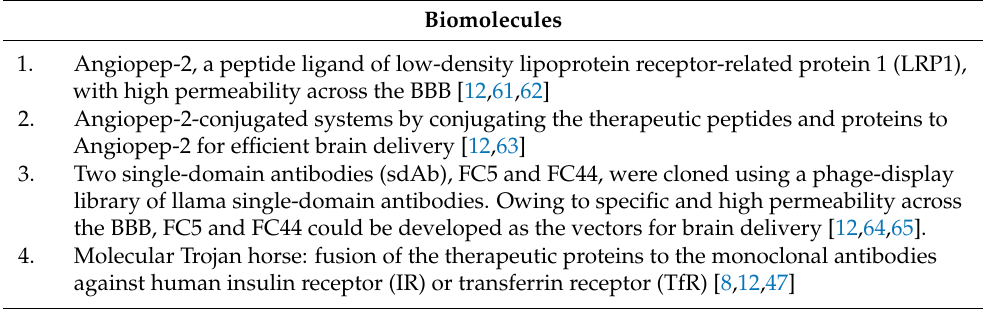
Table 3. Selected new peptides and antibodies with specific ability to cross the blood–brain